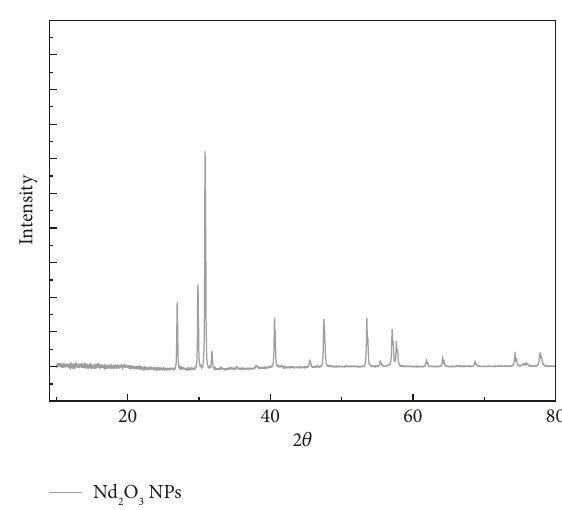
Figure 13: XRD pattern of Nd